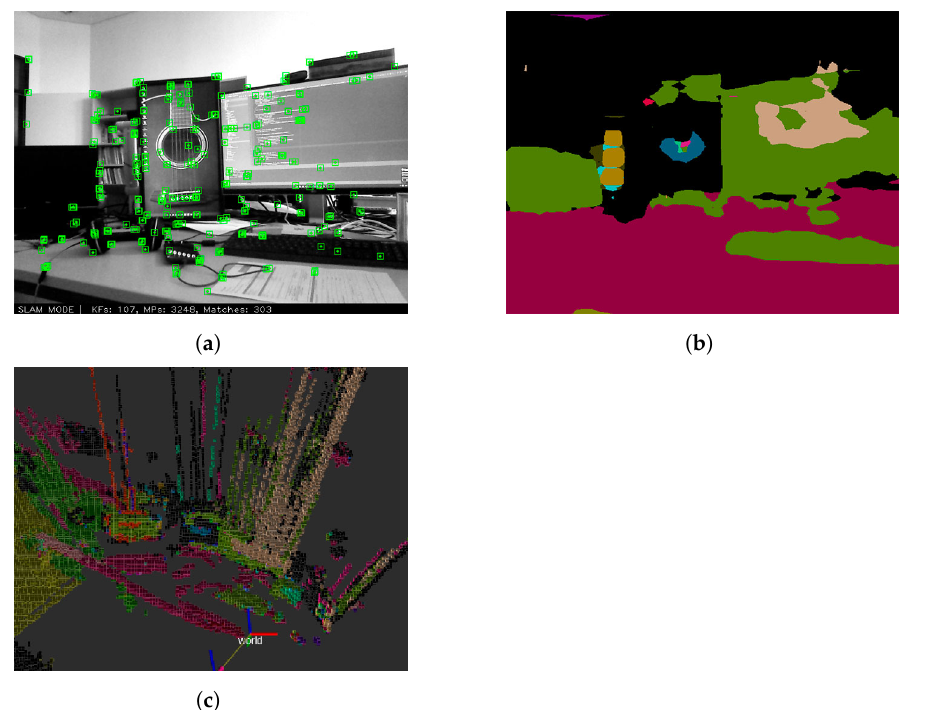
Figure 8. Example of semantic mapping using an RGB-D camera and the Semantic SLAM pack- age [79]: ( a ) camera image with feature extraction; ( b ) Segmented 2D image; ( c ) 3D semantic